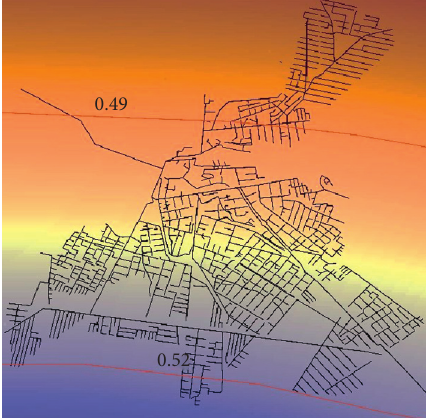
Figure 25: The total number of damage under PGA2% according to the VI method.